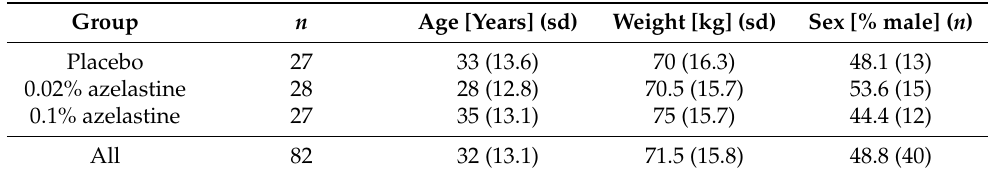
Table 1. Summary of the study population used for model development of the PK ‐ virus kinetic and symptom score models. Age and weight are summarized as medians and standard deviations (sd). Patients’ sex is summarized as the percentage and number of male patients.